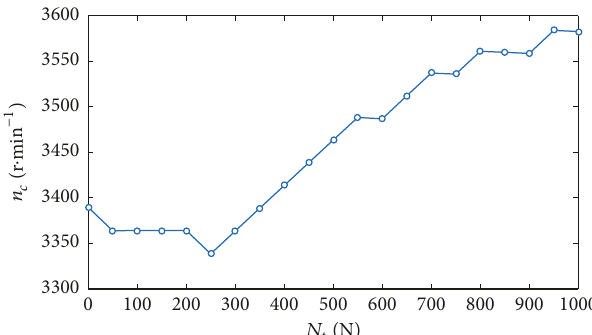
Figure 8: Relationship between the control force 𝑁 𝑡 and the critical speed of the rotation 𝑛 𝑐 .